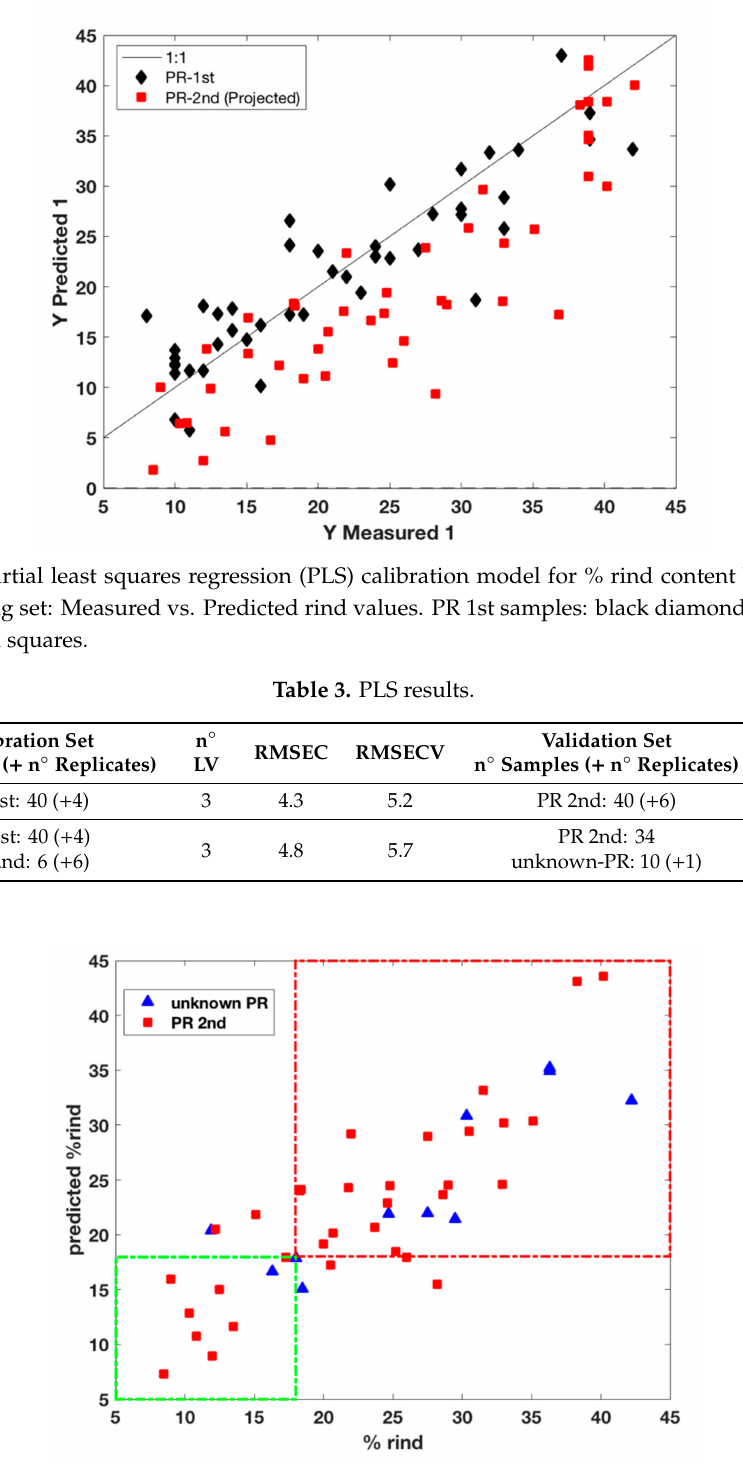
Figure 6. PLS calibration model for % rind content based on the updated calibration set (PR 1st + 6 PR 2nd): only predicted samples are shown, measured vs. predicted rind values. PR 2nd samples (test): red squares; unknown-PR: blue triangles. Samples falling in the green framed area are correctly seen as compliant and samples in the red frame are correctly seen as